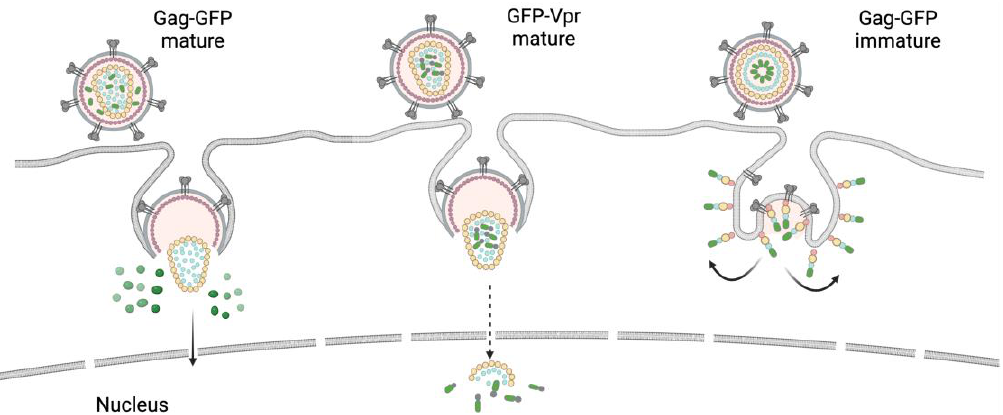
Figure 2. Three putative mechanisms of HIV VLPs fusion, disassembly, and reporter protein release in target cells depending on the VLP maturation status and cargo fusion with Gag or Vpr. The color codes of the structural domains of HIV Gag and reporter protein match those in the previous figure.